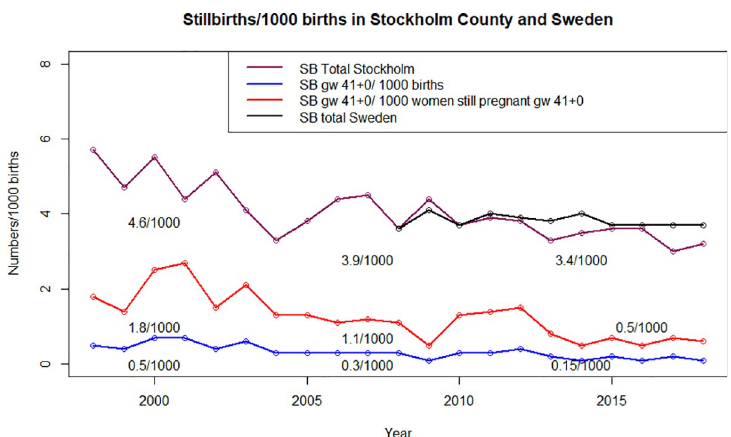
Fig 1. Total incidence of stillbirth in Stockholm county (violet). Incidence of stillbirth in Sweden (black). Incidence of stillbirth among women still pregnant at GW 41+0 number/1000 pregnancies (red) and incidence of stillbirth diagnosed from GW 41+0/ 1000 births (blue). The decreased incidences, violet, red and blue were all significant with p-value < 0.001. The incidence of stillbirth in Stockholm County has decreased comparing three time periods (1998- 2004, 2005-2013 and 2014-2018).